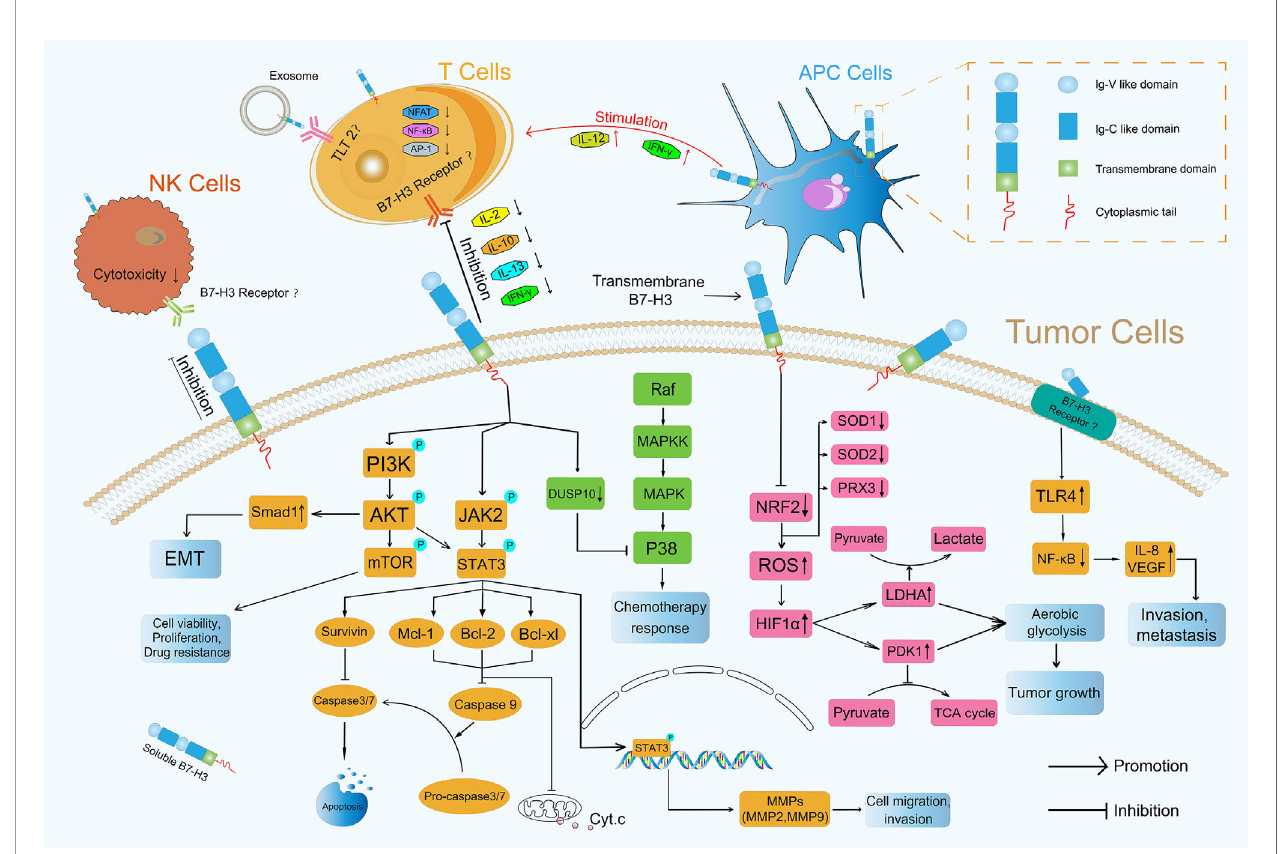
FIGURE 3 | Roles of B7-H3 in TME. B7-H3 can affect the progression of tumors through immune-dependent and nonimmune